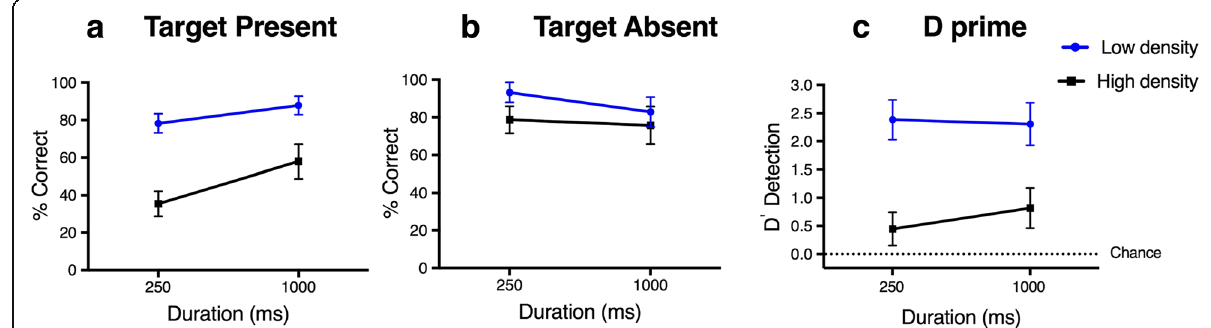
Fig. 3 Detection performance. a Average percentage correct on target present trials. b Average percentage correct on target absent trials. c Average d ′ on the detection task. Error bars represent 95% confidence